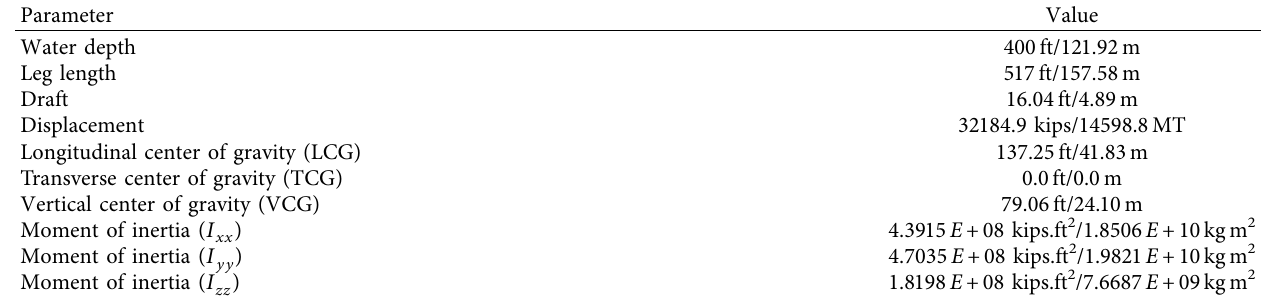
Table 3: Parameters for jack-up motion